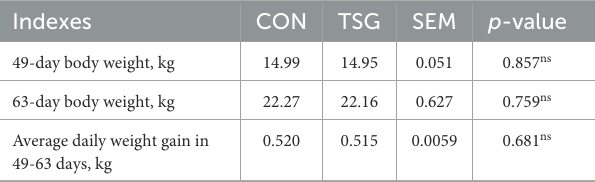
TABLE 1 Effect of short-distance transportation on the performance of piglets a